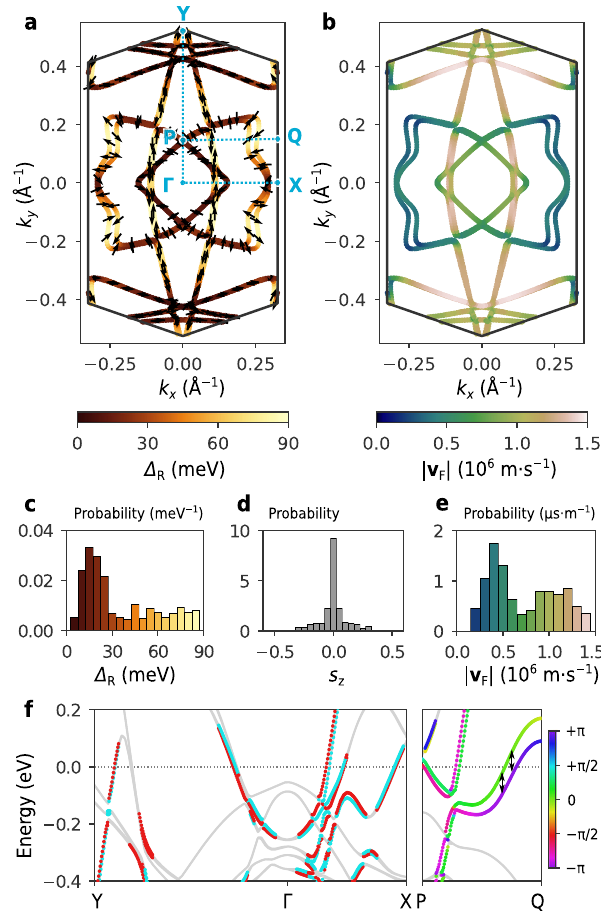
Fig. 3 Computed spin-split Fermi surface and Fermi velocity. a Fermi surface obtained from the DFT calculation. The colour indicates the magnitude of band splitting Δ R . Here, Δ R is de fi ned at each point on the Fermi surface as the energy difference from the partner band, as depicted by the double-headed arrows in ( f ). The small arrows indicate the orientation of the spins. b Fermi velocity ∣ v F ∣ computed from the band dispersion. c – e Histograms of Δ R ( c ), the z component of the spin, s z , ( d ), and ∣ v F ∣ ( e ) measured on the Fermi surface. These histograms re fl ect the weighting factor to the density of states given by d l / ∣ v F ∣ , where d l is the line segment on the Fermi surface. c , e share the same colour scales as ( a ) and ( b ), respectively. f Energy bands along Y – Γ – X and P – Q. The vertical axis shows the energy measured from the Fermi level. The colour indicates the relative direction of spin with respect to momentum; red and cyan correspond to the clockwise and counterclockwise helicities. For clarity, the states with Δ R < 10 meV are coloured in